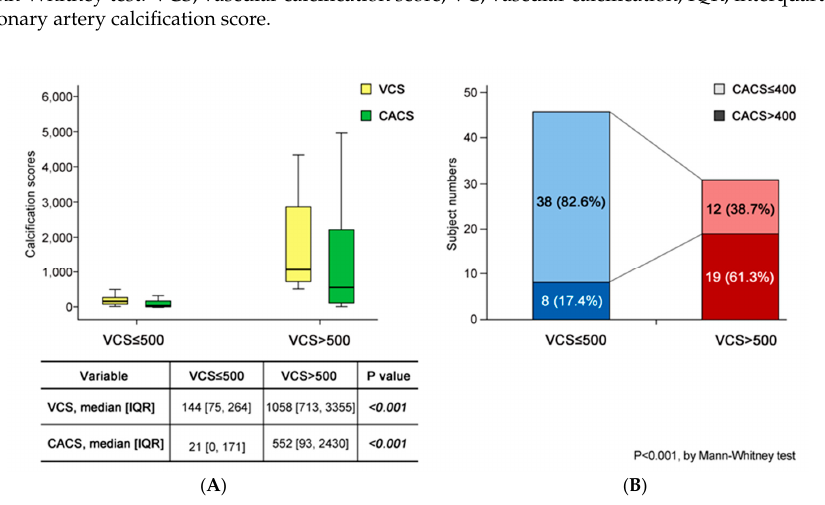
Figure 2. VCS and CACS in the two VCS groups A. Median VCS and CACS. B. Distribution of CACS > 400. ( A ) The median CACS of the lower ( ≤ 500) VCS group was 144, and that of the higher (>500) group was 1058. The CACS was different between the two groups (21 vs. 552). ( B ) There were eight (17%) patients in the lower VCS group, and 10 (61%) in the higher VCS group. Abbreviations: VCS, vascular calcification score; CACS, coronary artery calcium score.